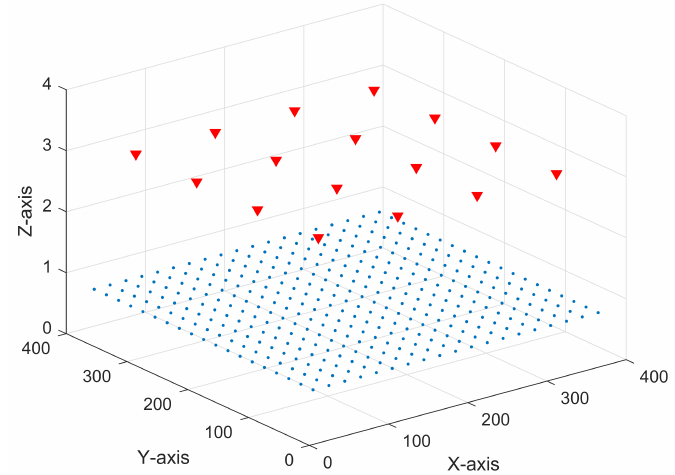
Figure 5. Grid of receivers at 0.75 m from the floor.